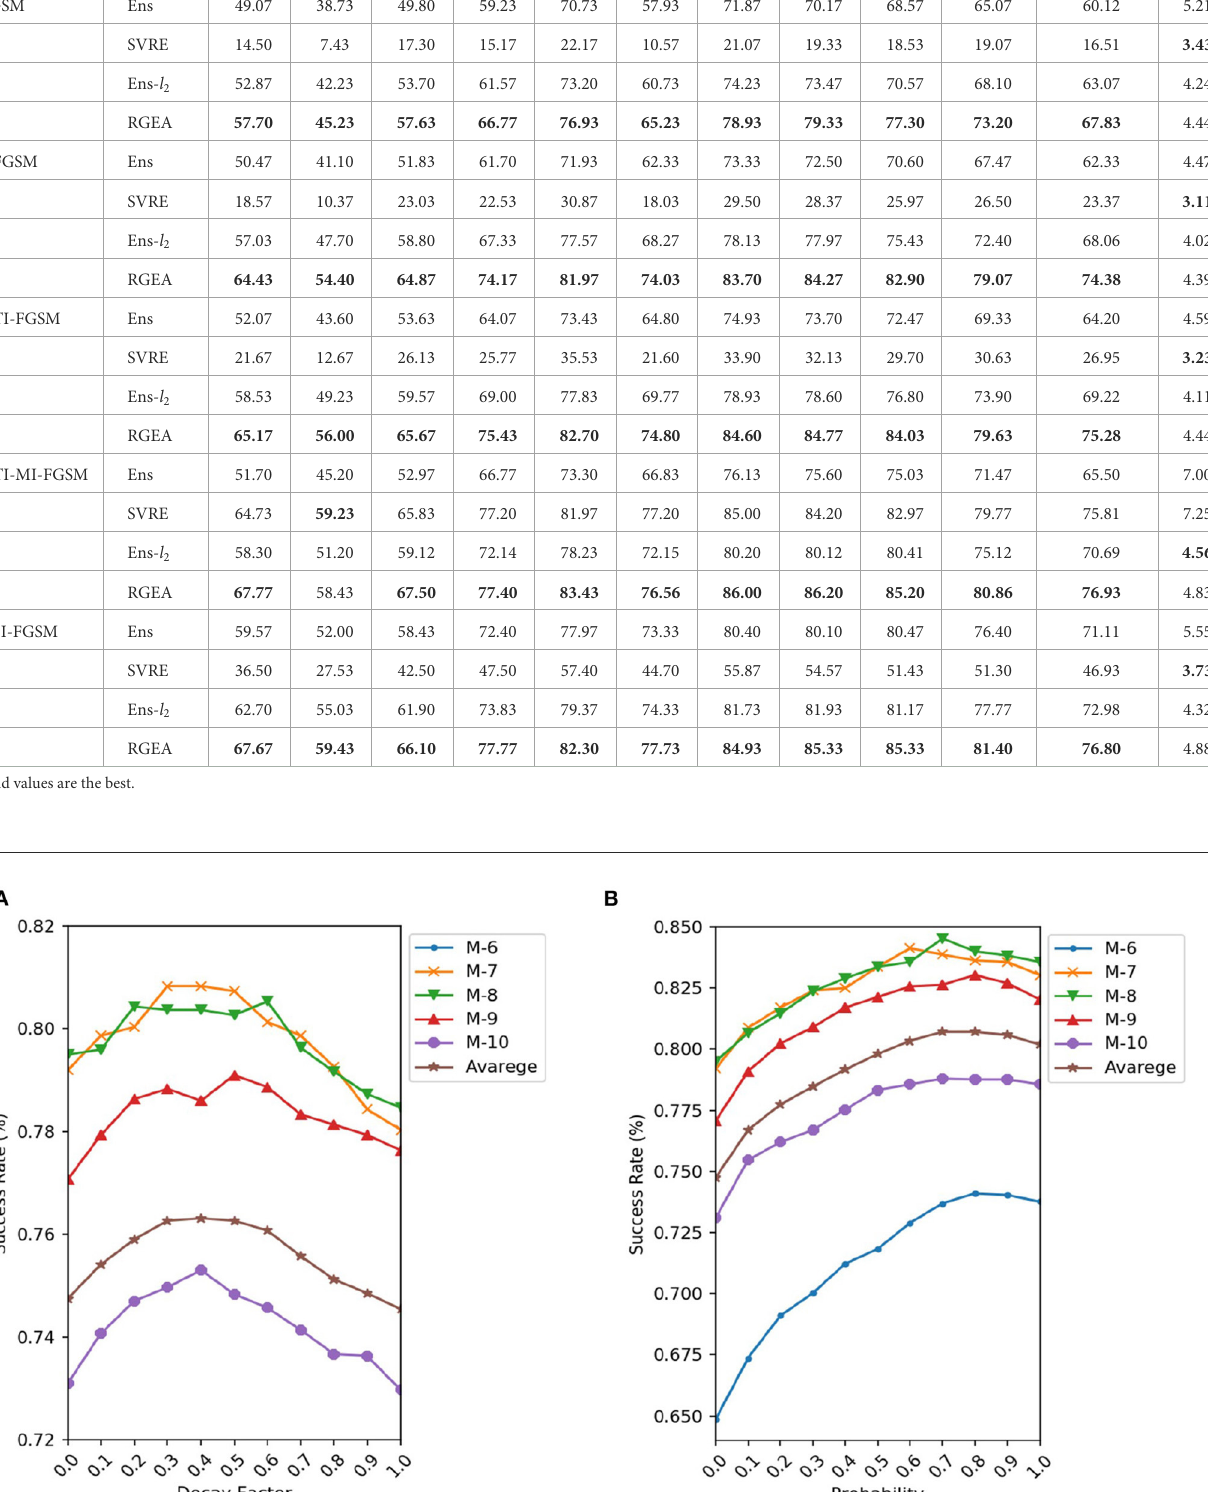
TABLE 2 Perturbation distance ( l 2 ) for the adversarial examples and success rate (%) of attacks on the normal model for Ens, SVRE, Ens- l 2 and RGEA, where the adversarial examples were all crafted on the surrogate models. Base